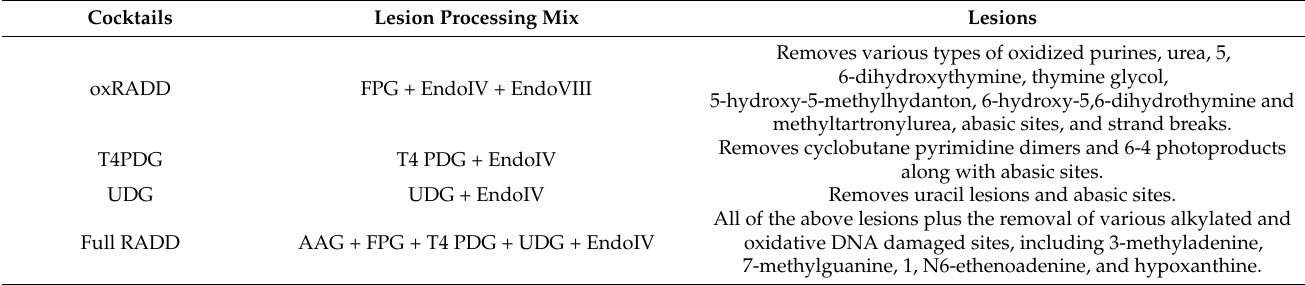
Table 2. RADD lesion-specific cocktails. For detecting specific lesion classes, the lesion processing mix is modified with only the specific DNA repair enzymes of interest for that lesion